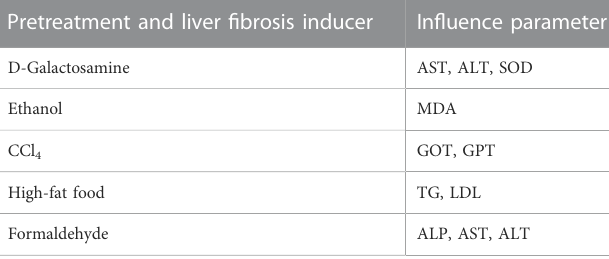
TABLE 2 Anti-hepatic fi brosis model of G. lucidum and the factors affecting it. Pretreatment and liver fi brosis inducer In fl uence